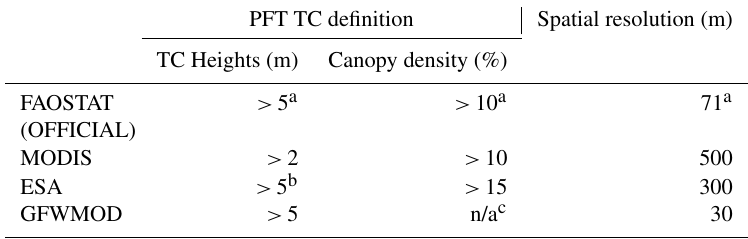
Table 4. Criteria for the classification of tree PFTs as inherited from the different LULC datasets (Table